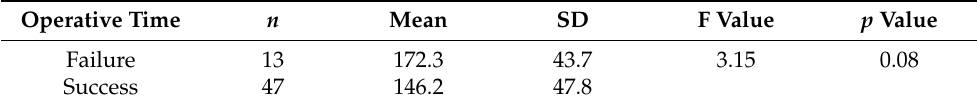
Table 3. Operative time difference between failure and success cases.